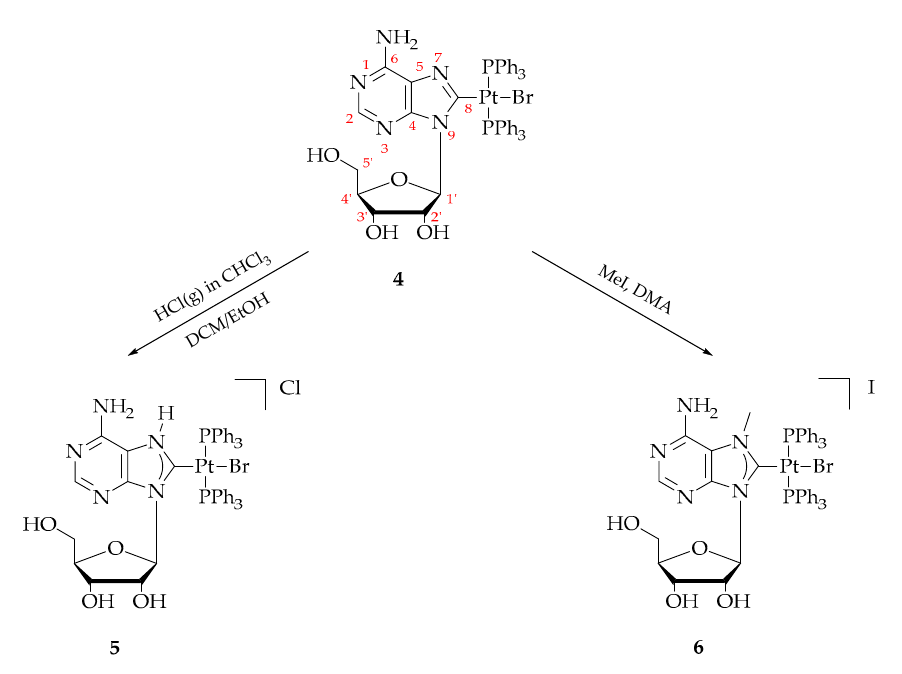
Molecules 2021 , 26 , x FOR PEER REVIEW